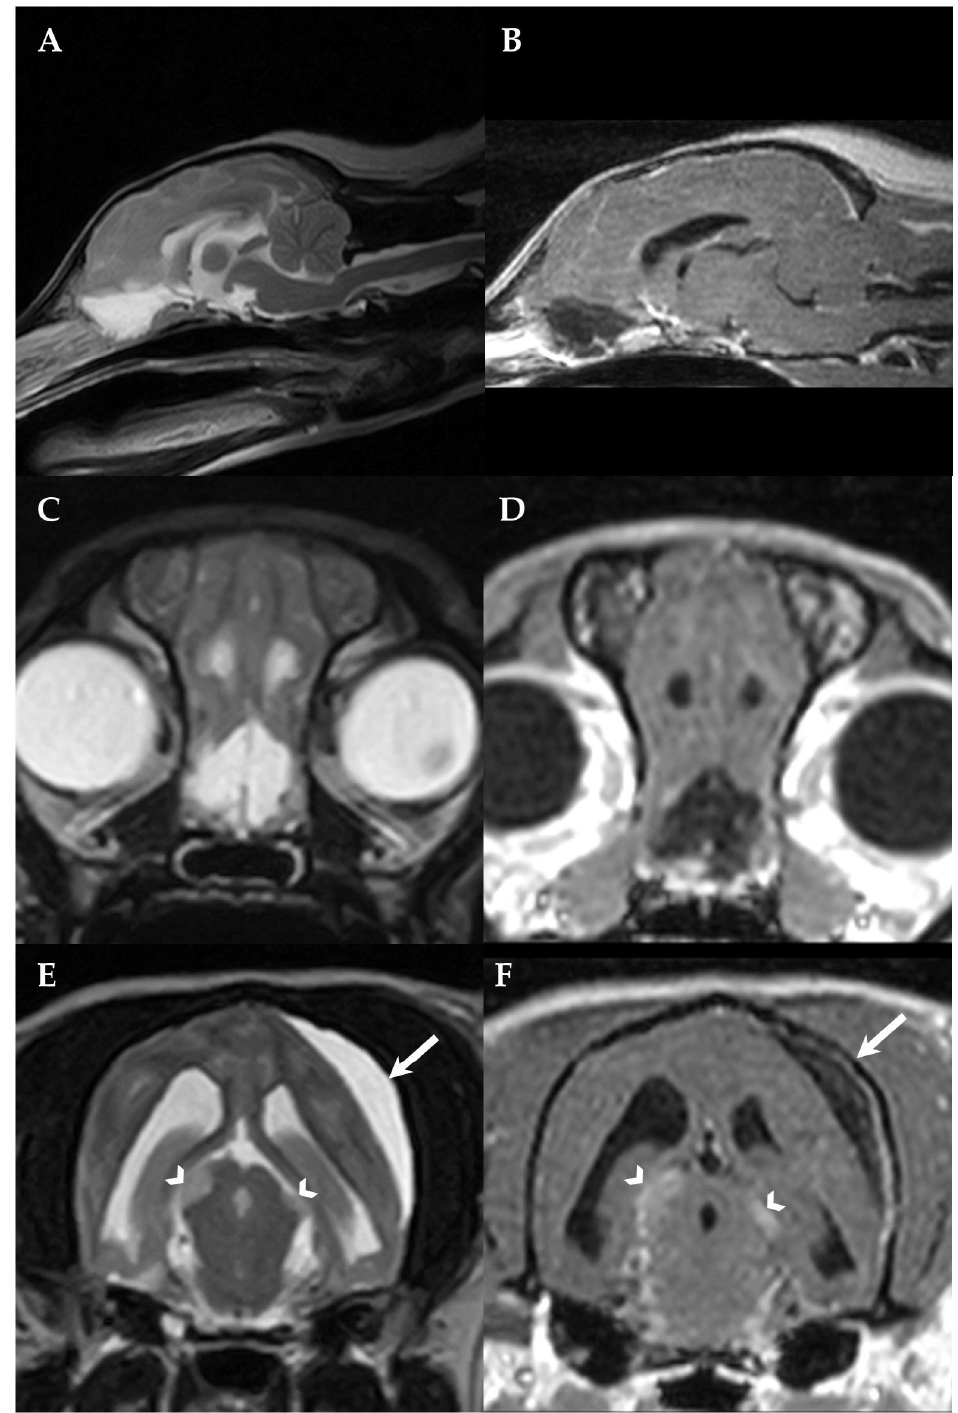
Figure 1. First MRI of the dog’s brain. Dorsal BASG ( A ), FLAIR ( B ) 3DT1W ( C ) and 3DT1W after contrast administration ( D ) showing the subdural fluid accumulation (SFA, arrows) compressing the left parietotemporal lobe and the left lateral ventricle. The SFA is BASG hyperintense ( A ), incompletely compressing on FLAIR ( B ), 3DT1W hypointense and demonstrates a mild contrast- enhancement of the adjacent dura mater ( D ). The left side of the patient is on the right side of the image.